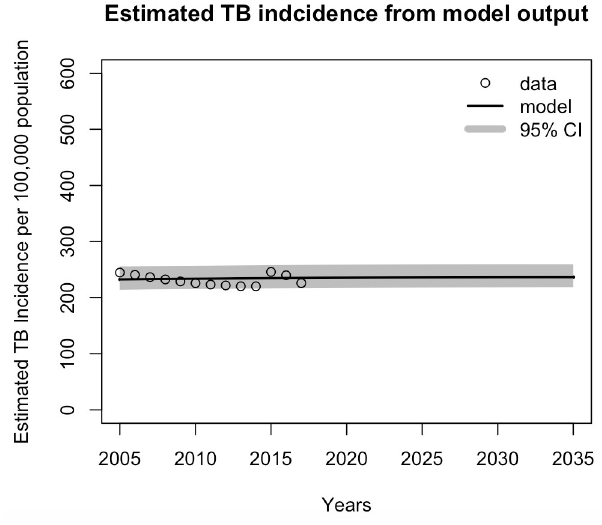
Fig 2. Model projection of estimated TB incidence per 100,000 population, with credible intervals. The black line shows the model results of estimated TB incidence, and the dots represent WHO data for estimated TB incidence.